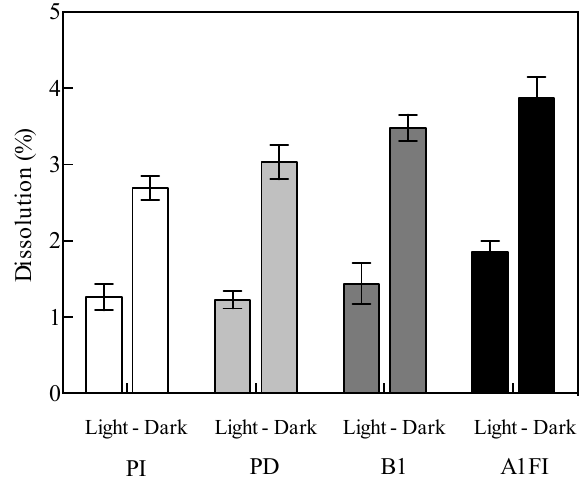
Figure 1. Dissolution (%) of CCA skeletons exposed to light (with photosynthetic microborers) and dark conditions (without photosynthetic microborers) and four p CO 2 -T scenarios over 8 weeks. Data correspond to means ± SEM ( n = 16 per light con- dition and p CO 2 -T treatment). p CO 2 -T levels correspond to pre- industrial (320µatm, 23 ◦ C), present-day (410µatm, 24 ◦ C), re- duced (600µatm, 26 ◦ C), and business-as usual (1000µatm, 28 ◦ C) CO 2 emission